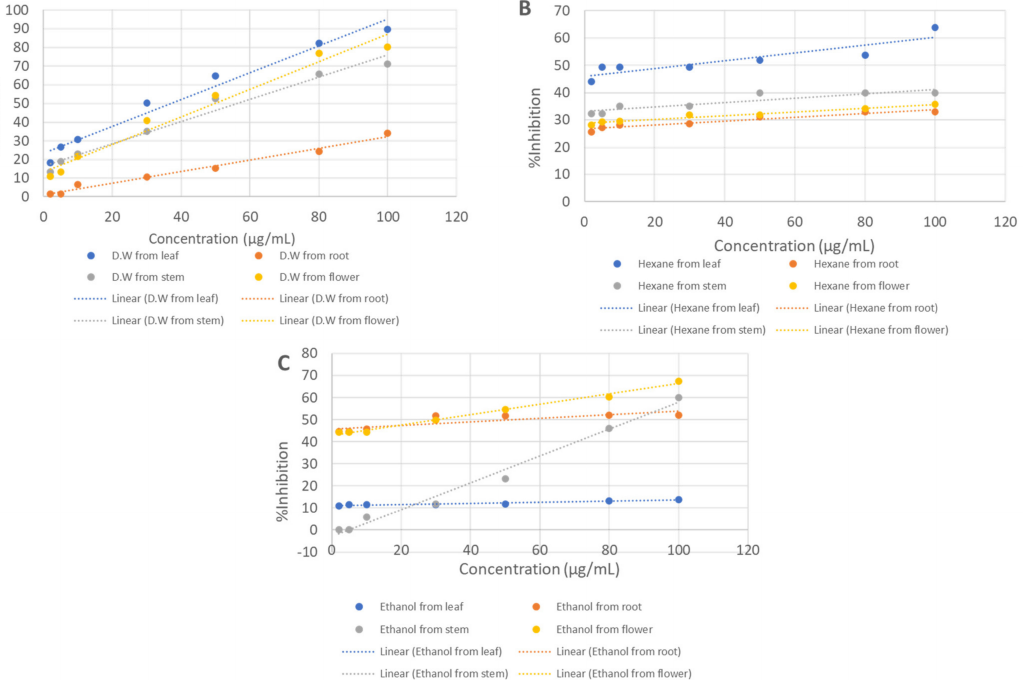
Figure 2. Antioxidant % inhibition vs. concentration ( µ g/mL) of water extracts ( A ), hexane extracts ( B ), and ethanol extracts ( C ) of the M. fruticosa botanical parts (leaf, root, stem, and